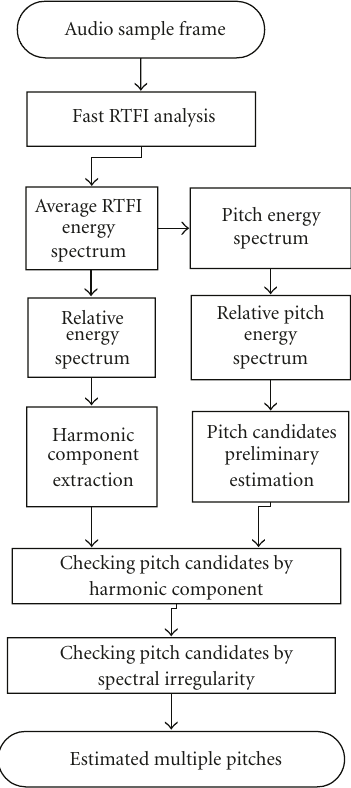
Figure 2: System overview of new polyphonic pitch estimation